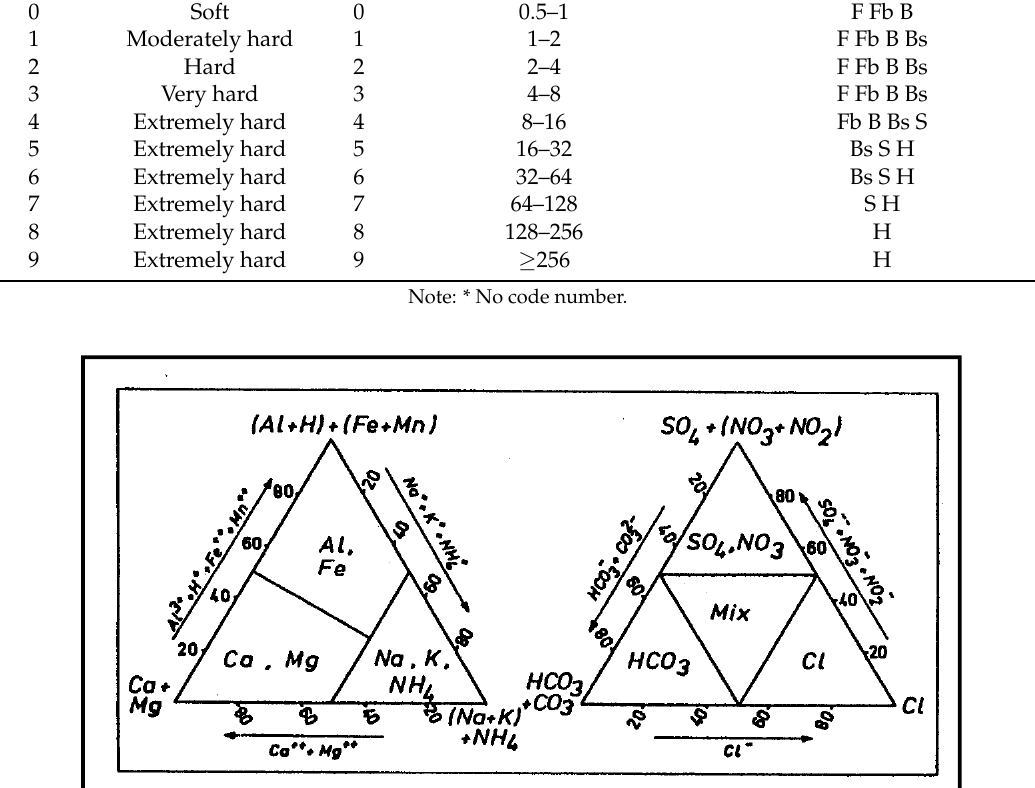
Figure 3. A ternary diagram showing the subdivision of types into subtypes [65]. Table 5. Subdivision of subtypes into classes according to {Na + + K + + Mg 2+ } corrected for sea salt [65].